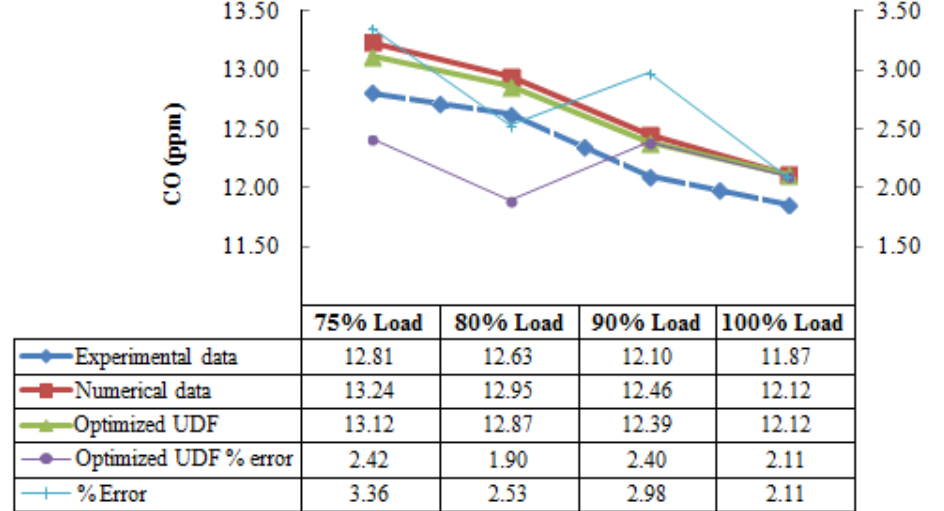
Figure 14. CO prediction at different load values. UDF, user-defined